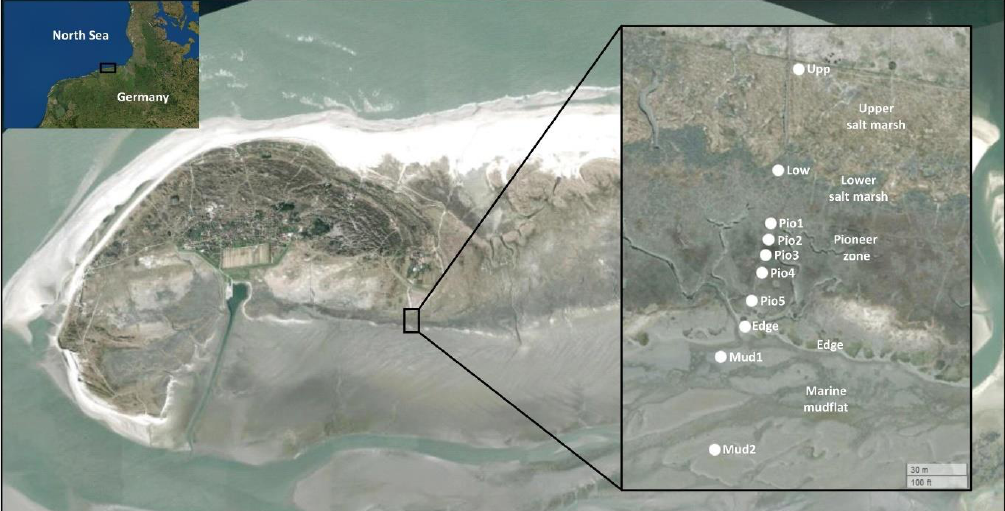
Figure 1. Location of sampling sites on the back barrier reef of the German Wadden Sea Island of Spiekeroog. The sampling sites are designated as “Upp” for the upper SM, “Low” for the lower SM, “Pio 1 – 5 ” for the five sampling sites from the pioneer zone, “Edge” for the shoreline and “Mud 1 – 2 ” for the mud-flats. The map was created in R using the leaflet package [33] with World Imagery [34] . Sources: Esri, DigitalGlobe, GeoEye, i-cubed, USDA FSA, USGS, AEX, Getmapping, Aerogrid, IGN, IGP, swisstopo, and the GIS User Community.